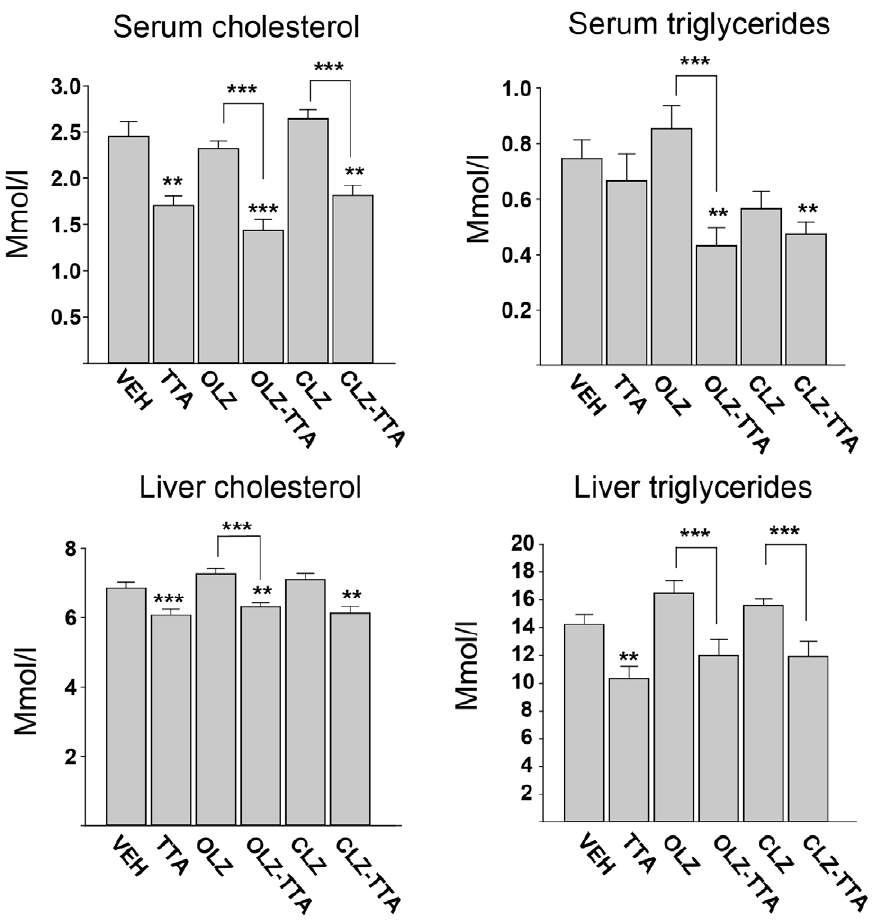
Figure 4. Fasting lipids in serum and liver at 8 weeks. Serum and liver lipids after chronic treatment with vehicle (VEH), olanzapine (OLZ), clozapine (CLZ), tetradecylthioacetic acid (TTA), or a combination of OLZ/CLZ + TTA. * P # 0.05, ** P # 0.01, *** P # 0.001.